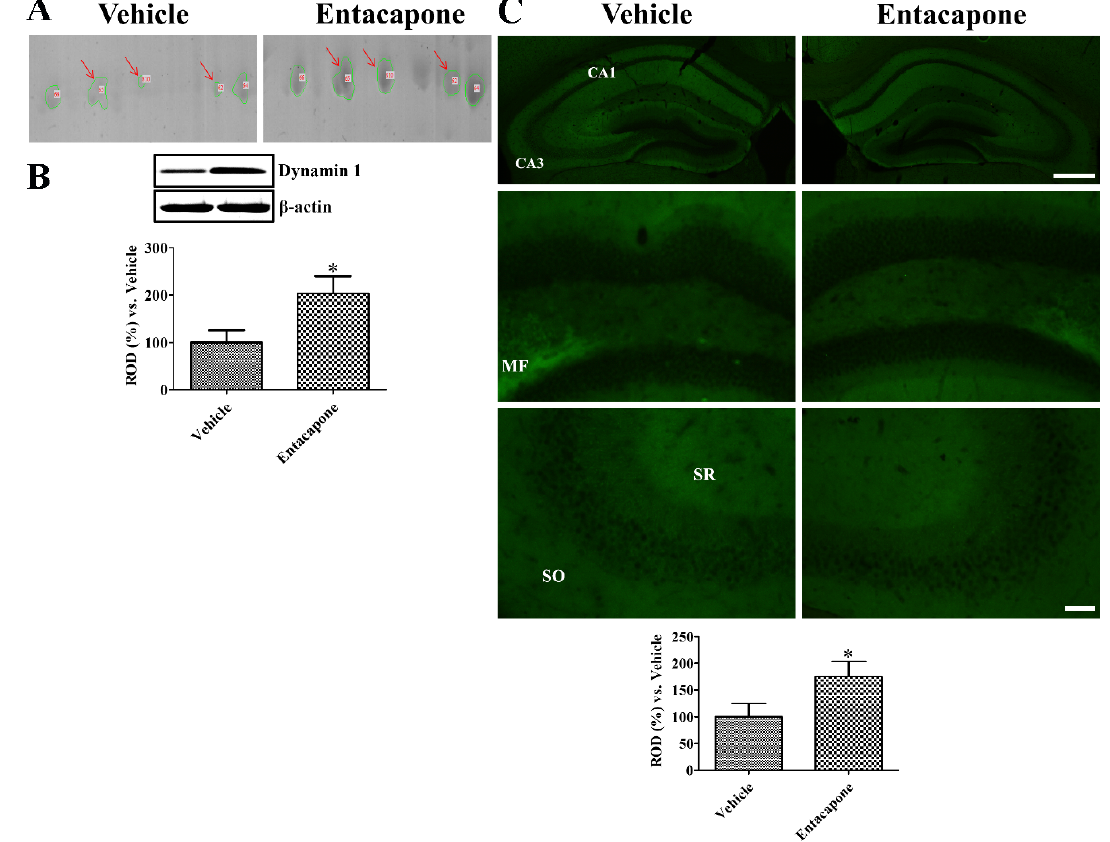
Figure 2. Dynamin 1 expression in the hippocampus of vehicle- and entacapone-treated groups based on proteomic ( A ), western blot ( B ), and immunohistochemical ( C ) study. Dynamin 1 are detected in three different spots using proteomic analysis and western blot analysis shows significant increases in dynamin 1 protein levels of entacapone-treated group compared to that in the control group. Western blot assays were performed in at least triplicate and bar graph represents the mean ± standard deviation. Dynamin 1 immunoreactivity is shown in the stratum radiatum (SR) and oriens (SO) of hippocampal CA1-CA3 region and mossy fibers (MFs) . Scale bar = 400 μm (low magnification), 50 μm (high magnification). Three sections , 150 μm apart, are selected between 1.7 and 2.3 mm caudal to the bregma in each animal. Relative optical densities (ROD) are expressed as a percentage of the value of dynamin 1 protein levels and immunoreactivity in the vehicle-treated group ( n = 5 in each group; * p < 0.05, significantly different from the vehicle-treated group). The bars indicate the mean values ± standard deviation.